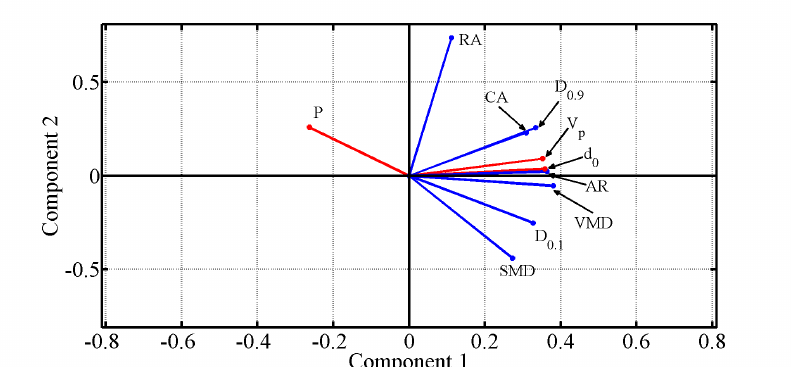
Figure 2. Biplot of the principal components (PCs) for application quality descriptors and operat- ing conditions.